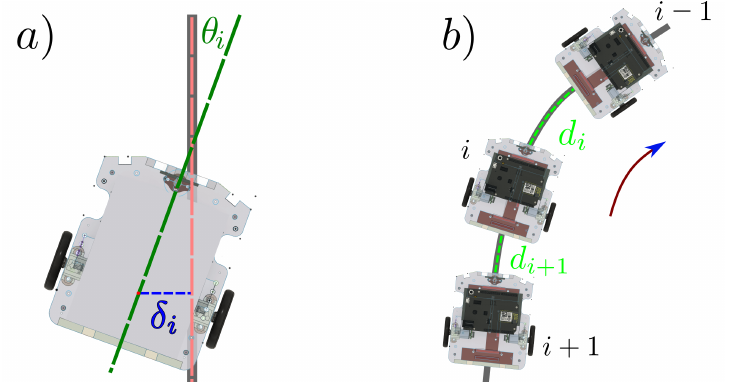
Figure 1. Line-following control: ( a ) lateral problem ( b ) longitudinal problem.